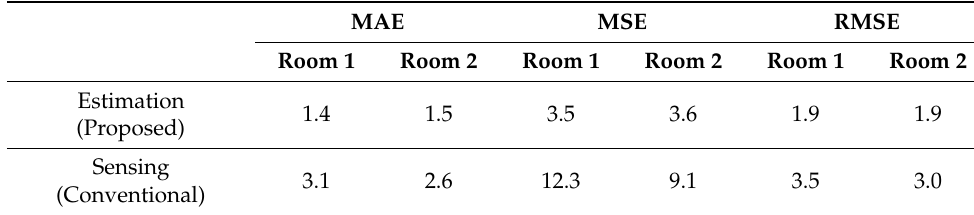
Table 2. Evaluation of estimated occupancy.